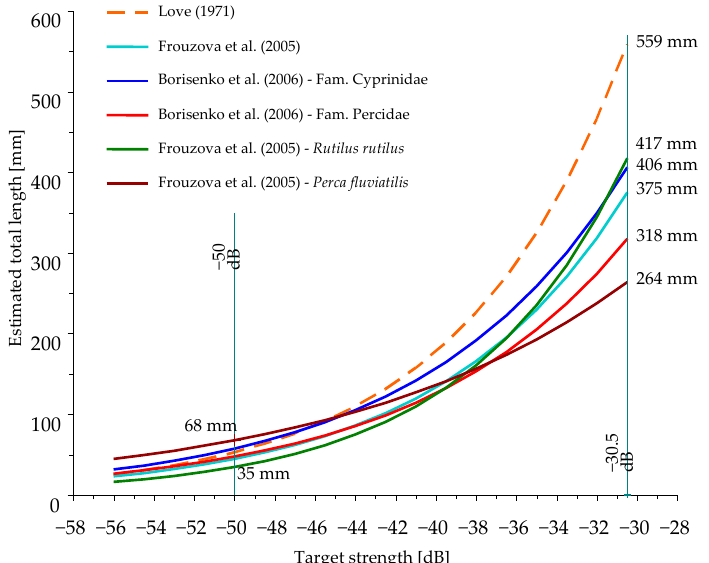
Figure 1. Comparison of some TS – TL relationships (dorsal aspect) from the literature [2,7,21].